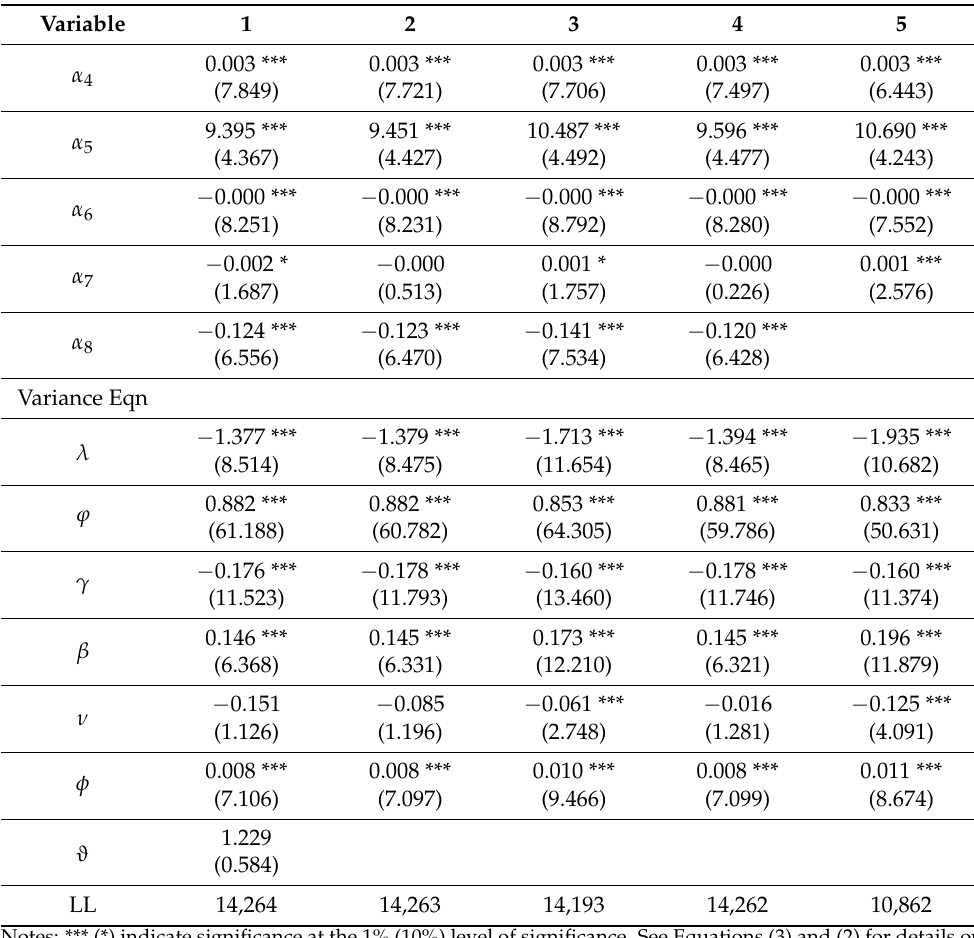
Table 3. Estimates of the event study using the EGARCH model with exchange rates.